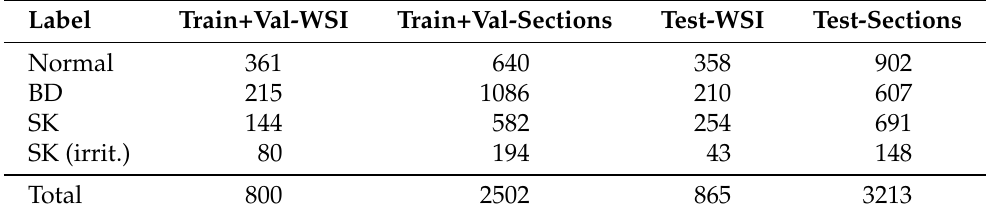
Table 2. Distribution of the data from Center 0. The number of WSIs are provided, as well as the number of tissue sections that were segmented from these, e.g., in Figure 1, there are 4 tissue sections (very small sections are filtered out). Train+Val refers to the part of the data that was used for the training and validation of the